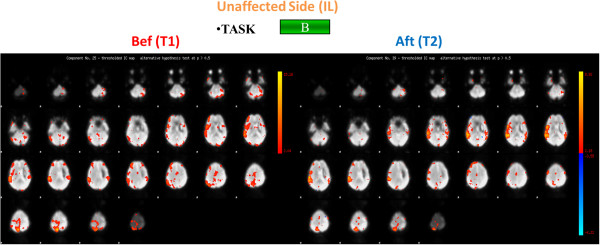
Brain activation for the stroke patient: task B, unaffected side. Brain activation for the Stroke Patient for task B (on the bottom) for the unaffected side (ipsilateral (IL)) before (Bef) (on the left) and after (Aft) (on the right) the rehabilitation treatment.